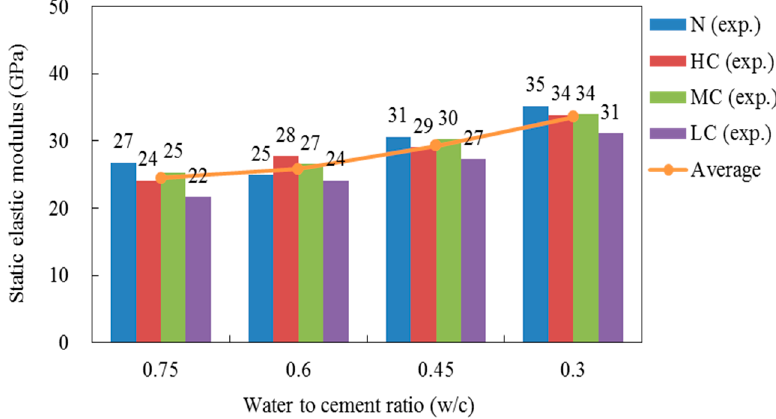
Figure 10. Static modulus at 28 days with different water-to-cement ratios.